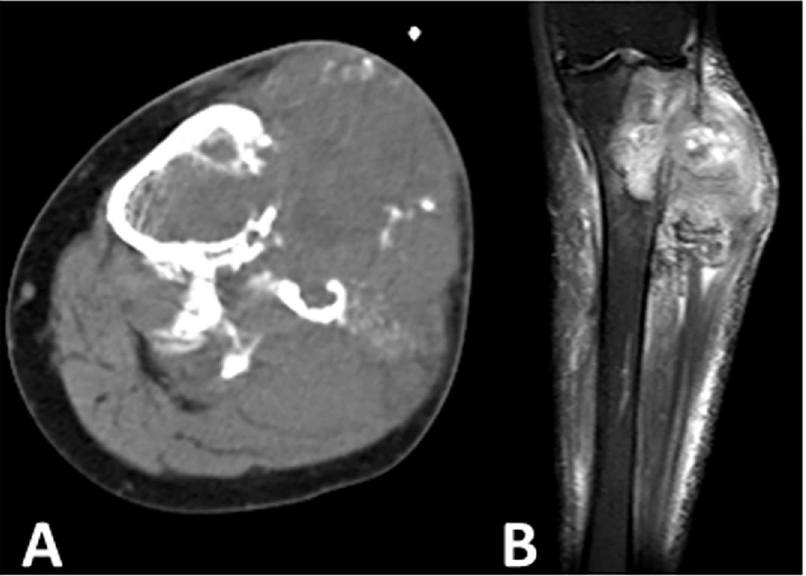
Fig 5. Dedifferentiated chondrosarcoma of the left proximal tibia and fibula in a 49-year-old woman (Case 9). (A).CT showeda flocculentshapedchondralmatrix mineralization with marginal irregularshaped ossification and a soft tissue mass (B). Fat-suppressed coronal T2-weighted image showedheterogeneous signalintensity.